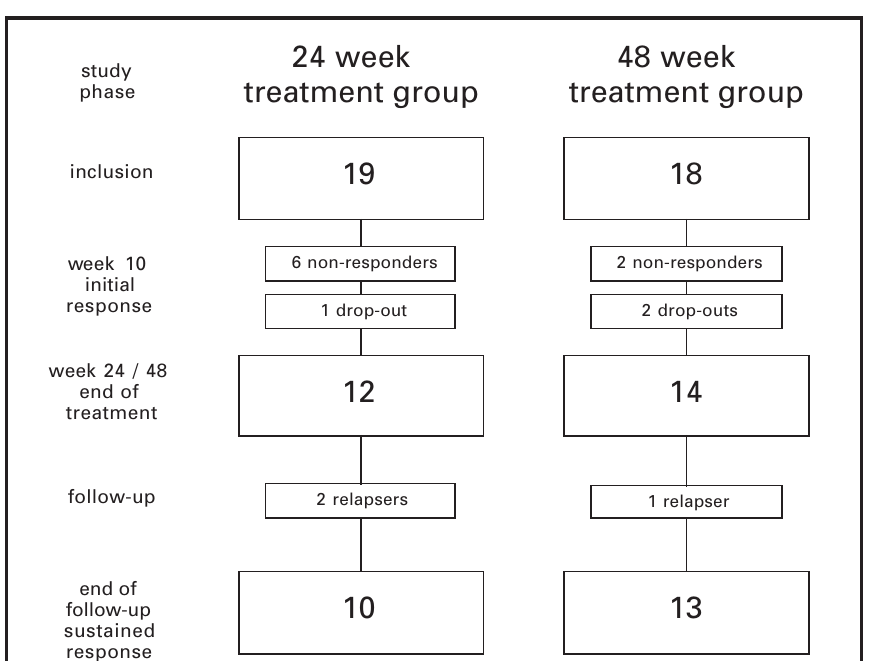
Figure 1 Flow chart of the results of 37 included patients in the 24 week and 48 week treatment